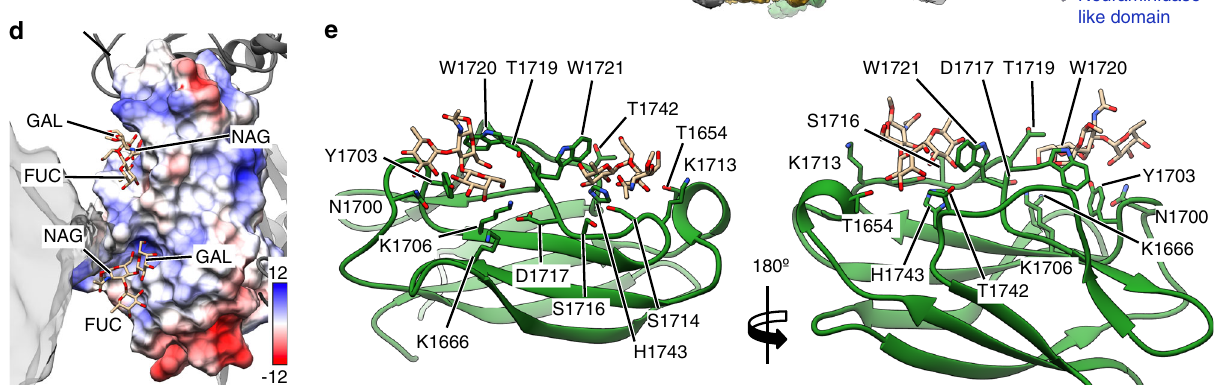
Fig. 3 Structure of Pl-TcdA1 with BSA-Lewis X. a Representative reference-free 2D class averages of cryo-EM images of Pl-TcdA1 with crosslinked BSA- Lewis X obtained by ISAC and resampled to the original pixel size. Scale bar, 20 nm. b Cryo-EM map of Pl-TcdA1 with BSA-Lewis X. The protomers are colored individually. Density corresponding to BSA-Lewis X (gray) is shown at lower binarization threshold. c Model of one protomer of Pl-TcdA1 together with the cryo-EM density of BSA-Lewis X (gray) at low binarization threshold. The domains of Pl-TcdA1 are colored individually. BSA-Lewis X is attached to receptor binding domain D (RBD D). d Surface representation of RBD D, colored according to the Coulomb potential (kcal mol − 1 e − 1 ) at pH 7.0. Two docked conformations of Lewis X are shown as stick representations. The docking score is − 4.5 kcal mol − 1 for both conformations. The cryo-EM density map corresponding to BSA-Lewis X is transparent gray. FUC: fucose, GAL: galactose, NAG: N -acetylglucosamine. e Detailed view of RBD D (green) with two docked Lewis X molecules. Sidechains that contact the docked molecules are